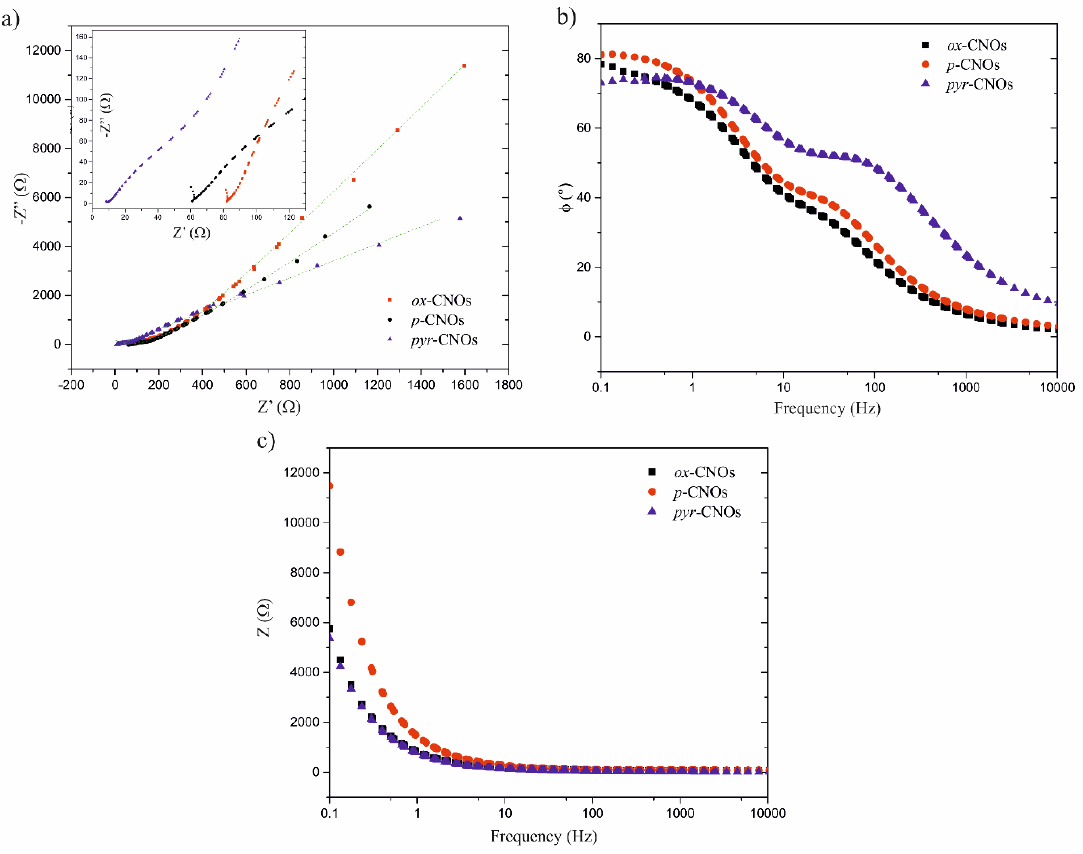
Figure 11. ( a ) Nyquist plot (Z’’ vs. Z’). ( b ) Bode plot ( ϕ vs. f ). ( c ) Bode plot ( Z vs. f ) obtained for the GCE that was modified with the CNOs.